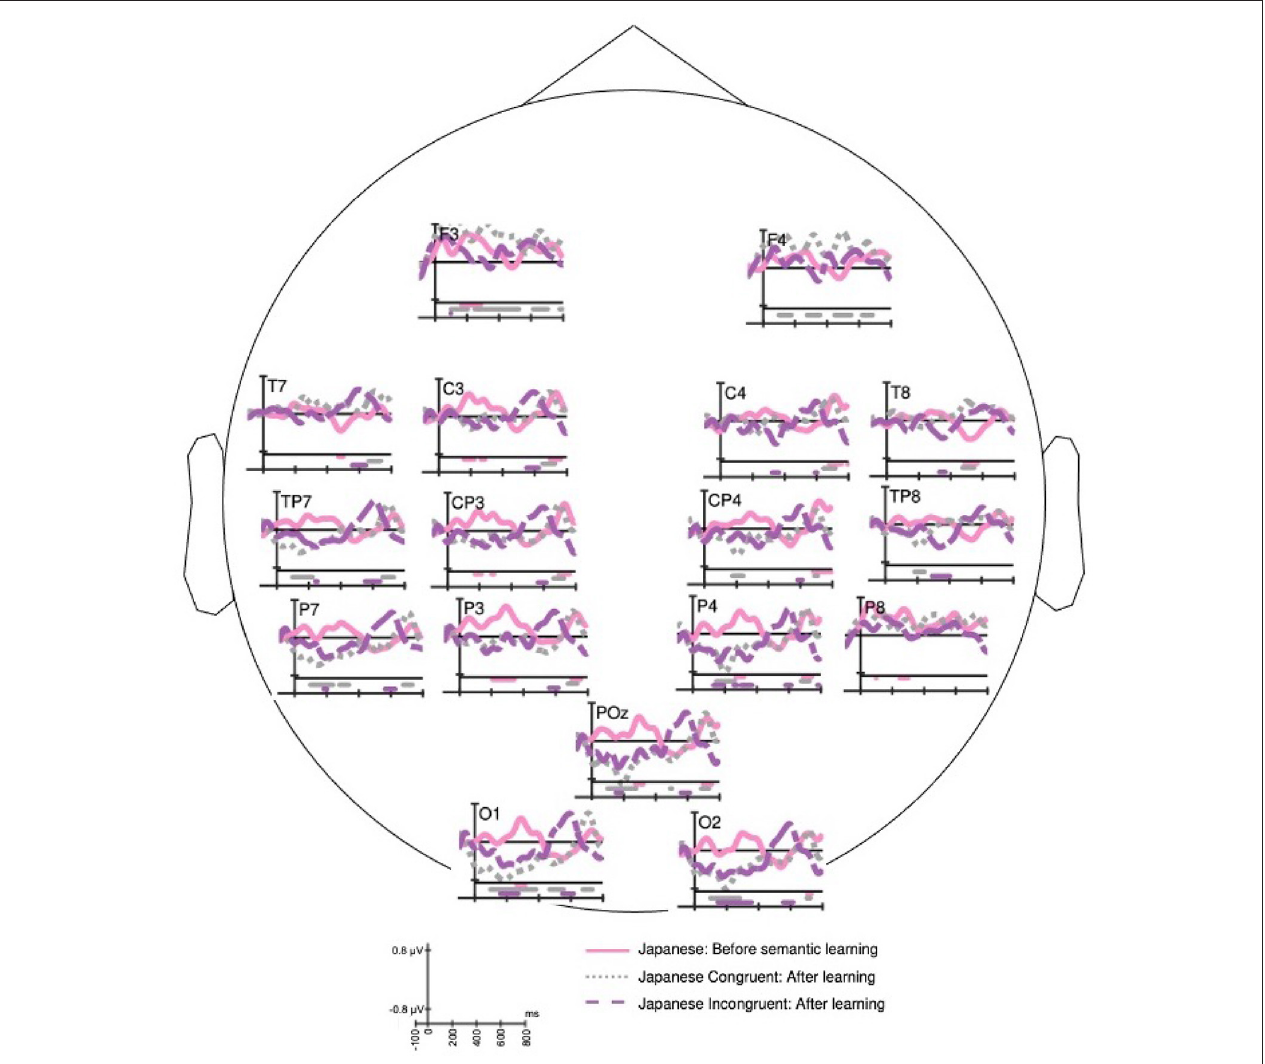
FIGURE 4 | The grand average of event-related potential (ERP) responses to Japanese end-word before learning its meaning (solid), Japanese congruent end-word (dotted), and Japanese in-congruent end-word (dashed) after learning the meaning. The horizontal bars drawn in the bottom of each plot signify the time regions with significant ( t -test with p < 0.05) ERP amplitude from the value of 0. The bars have the same color of the associated waveform.